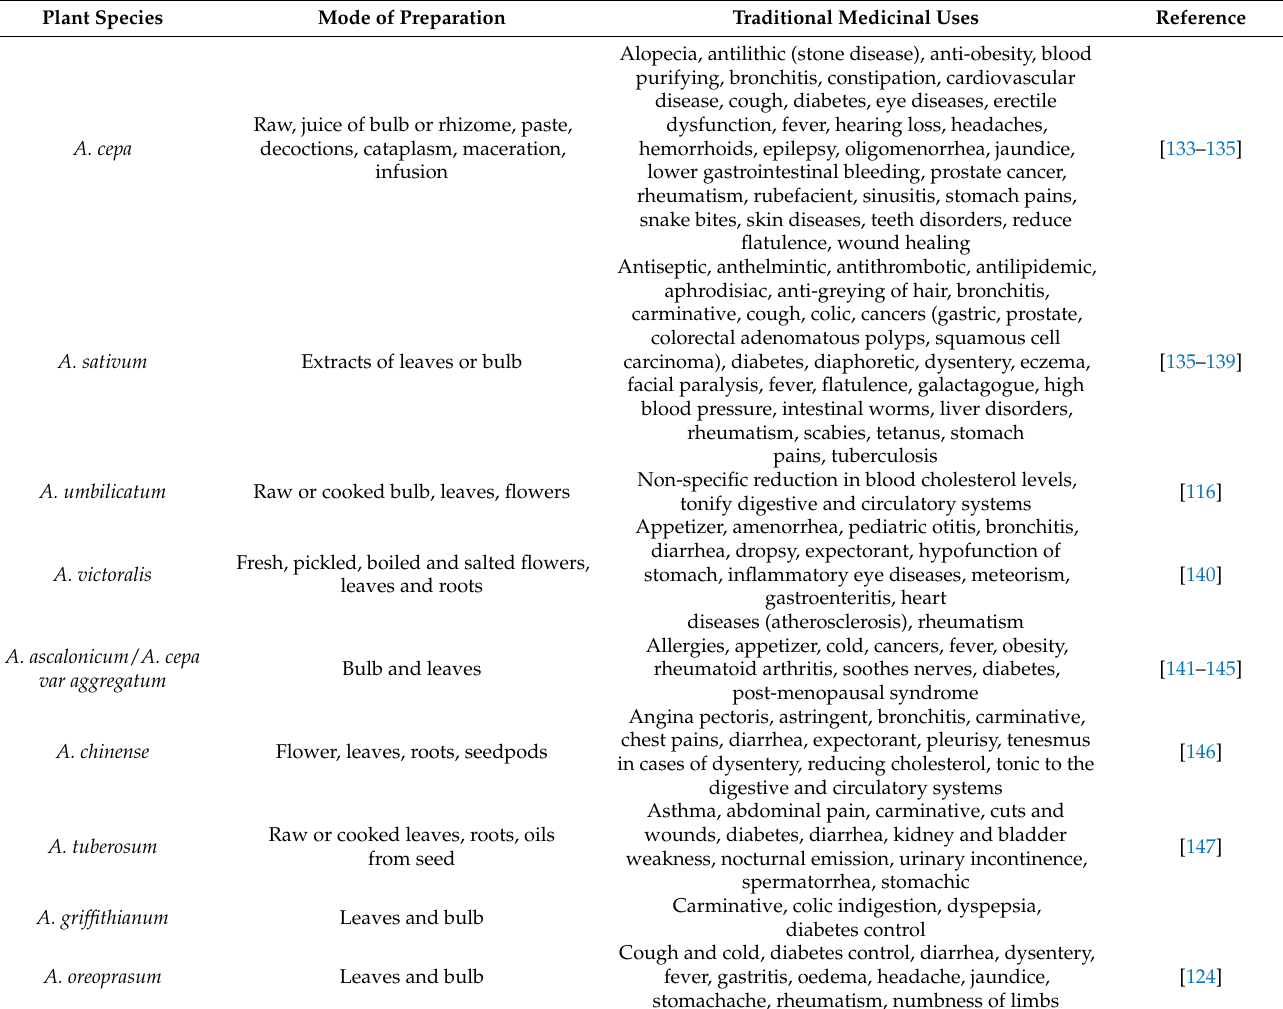
Table 9. Traditional medicinal uses of Allium